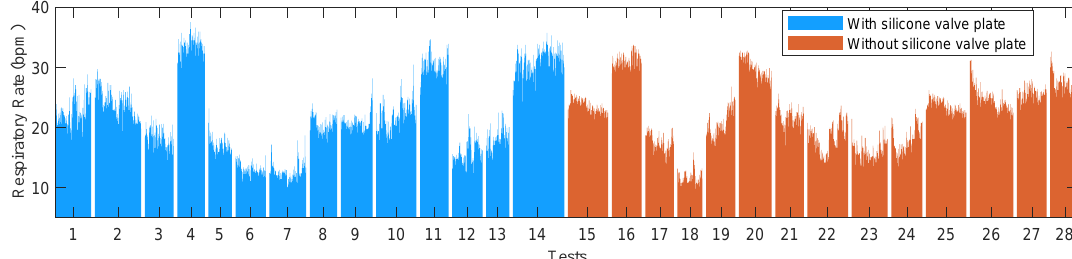
Figure 11. The respiratory rates of 28 tests measured by the button in the experiments of stationary mode.